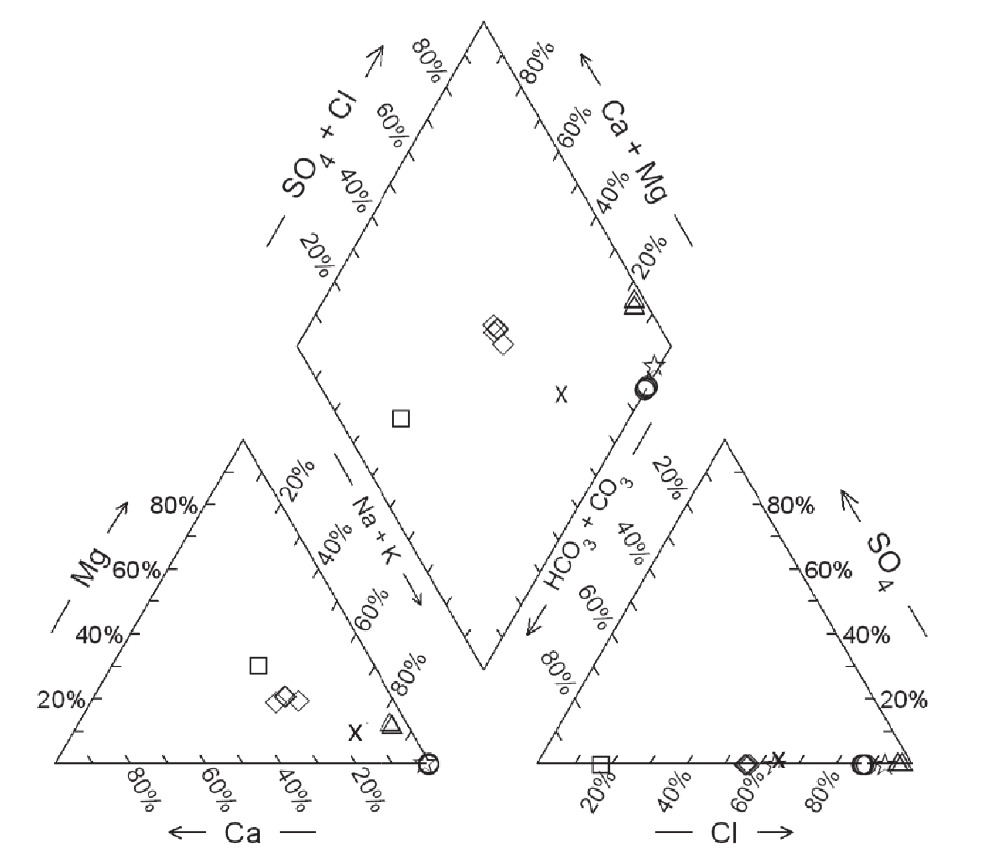
Figure 1a. Water geochemical features. Piper diagram for the water samples. Triangle, Mirandola; circle, Concordia; diamond, Bellentani; square, Menozzi; cross, Bassoli; star,